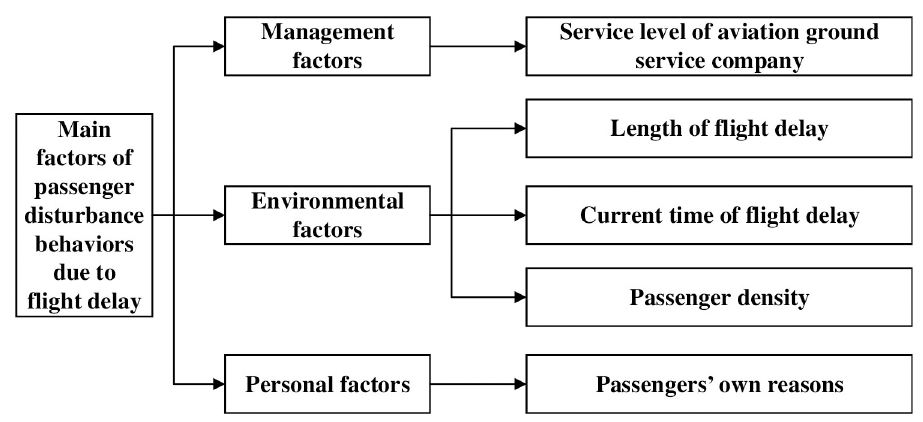
Fig 1. Main factors influencing disruptive behavior by passengers.